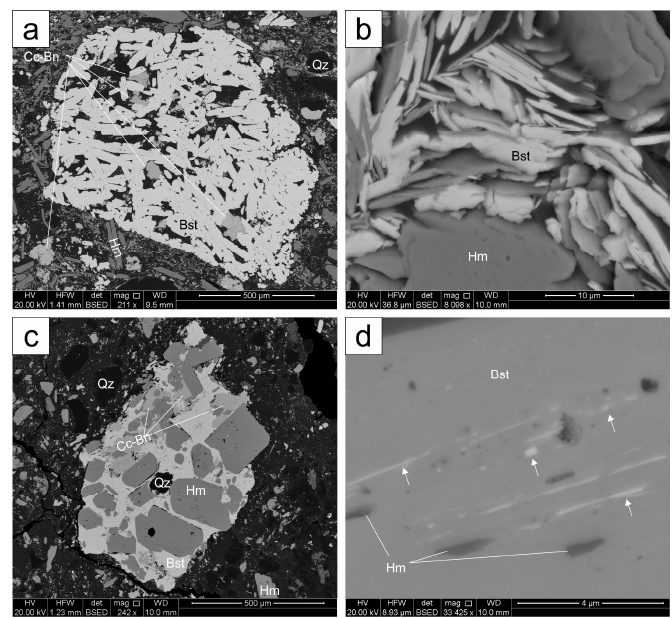
Figure 5. BSE images showing petrographic aspects of clast replacement bastnäsite: ( a ) Bladed aggregates of bastnäsite psuedomorphing the outline of a replaced clast (sample RX6726). Qz-quartz, Cc-chalcocite, Bn-bornite, Hm-hematite; ( b ) Feather-like bastnäsite with hematite (sample RX6713); ( c ) Bastnäsite forming a cement around hematite within breccia clast (sample RX6723); ( d ) Coarse-grained bastnäsite with hematite inclusions; arrows indicate brighter bands, which may be richer in HREE or contain more F and less CO 3 (sample RX6714).